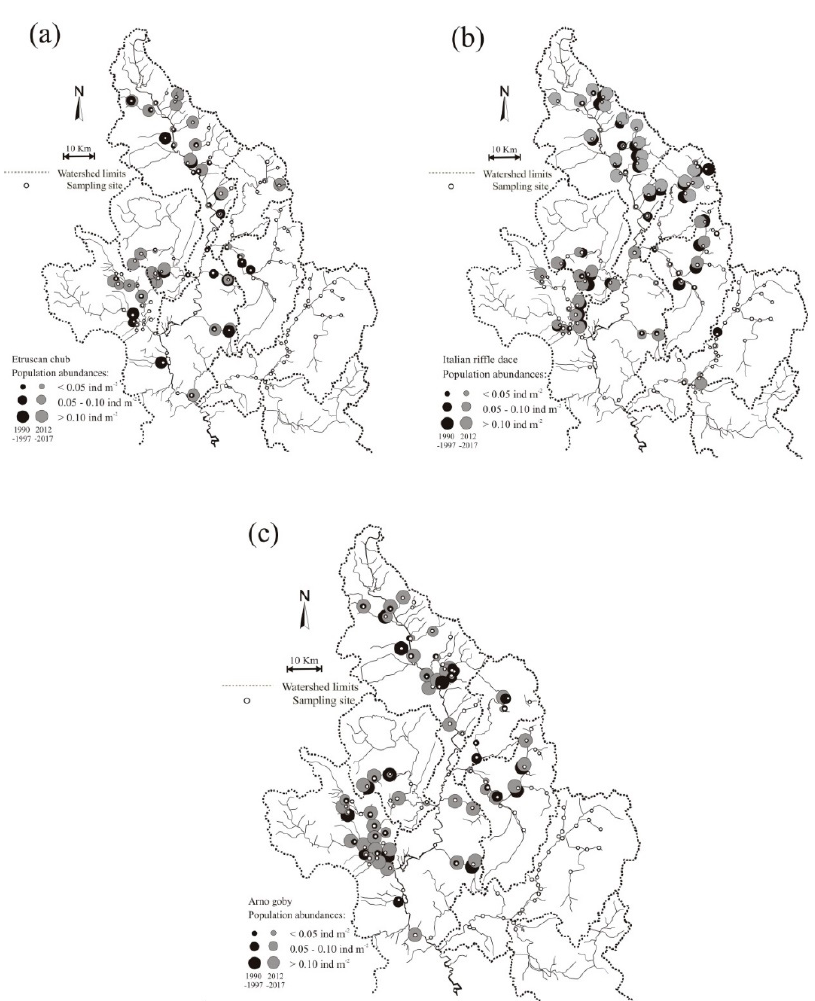
Figure 4. Comparison of the distribution and population abundances between the periods 1990–1997 (black circles) and 2012–2017 (grey circles) for: ( a ) Squalius lucumonis ; ( b ) Telestes muticellus ; ( c ) Padogobius nigricans .